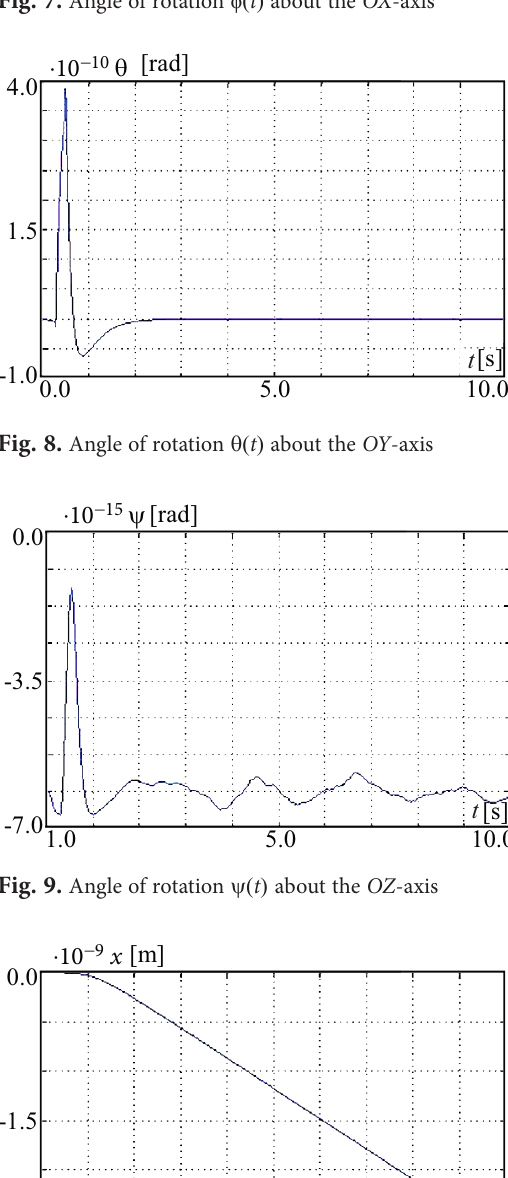
Fig. 7. Angle of rotation φ( t ) about the OX -axis